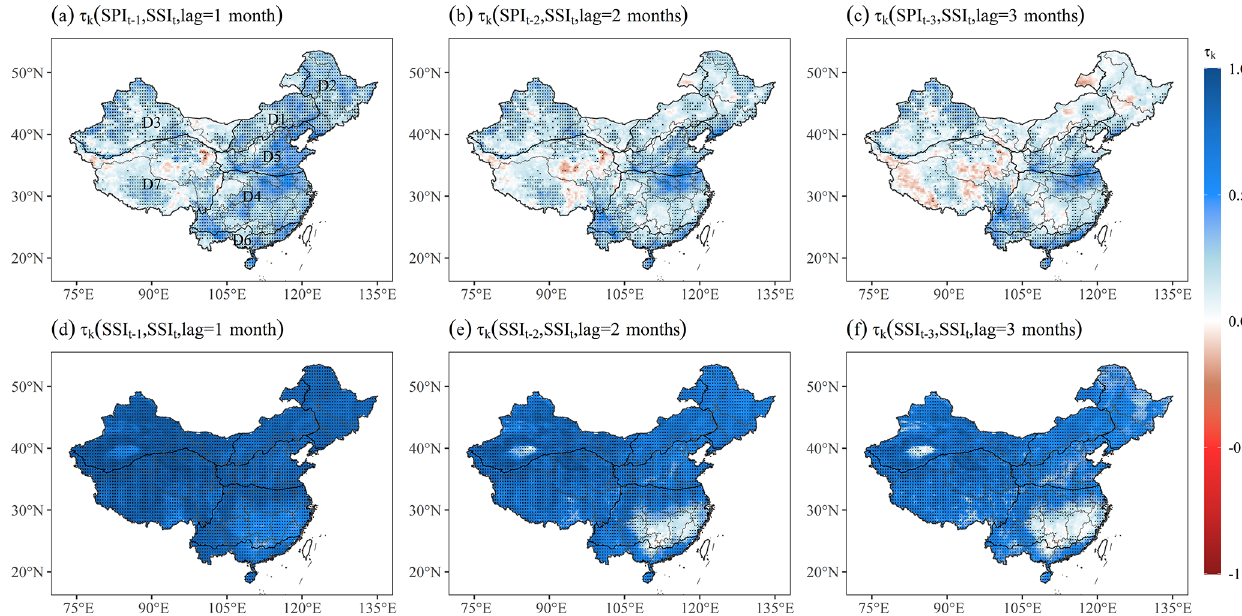
Figure 4. Spatial patterns of 1- to 3-month lag times for the Kendall’s correlation coefficient ( τ k ) between SPI t − i and SSI t (where t denotes August, and i is the 1- to 3-month lag time) (top row) and between SSI t − i and SSI t (bottom row) for August during 1961–2018 over China. Note that the stippling indicates where τ k is at a 0.05 significance level, which is corrected via the false discovery rate (FDR) of